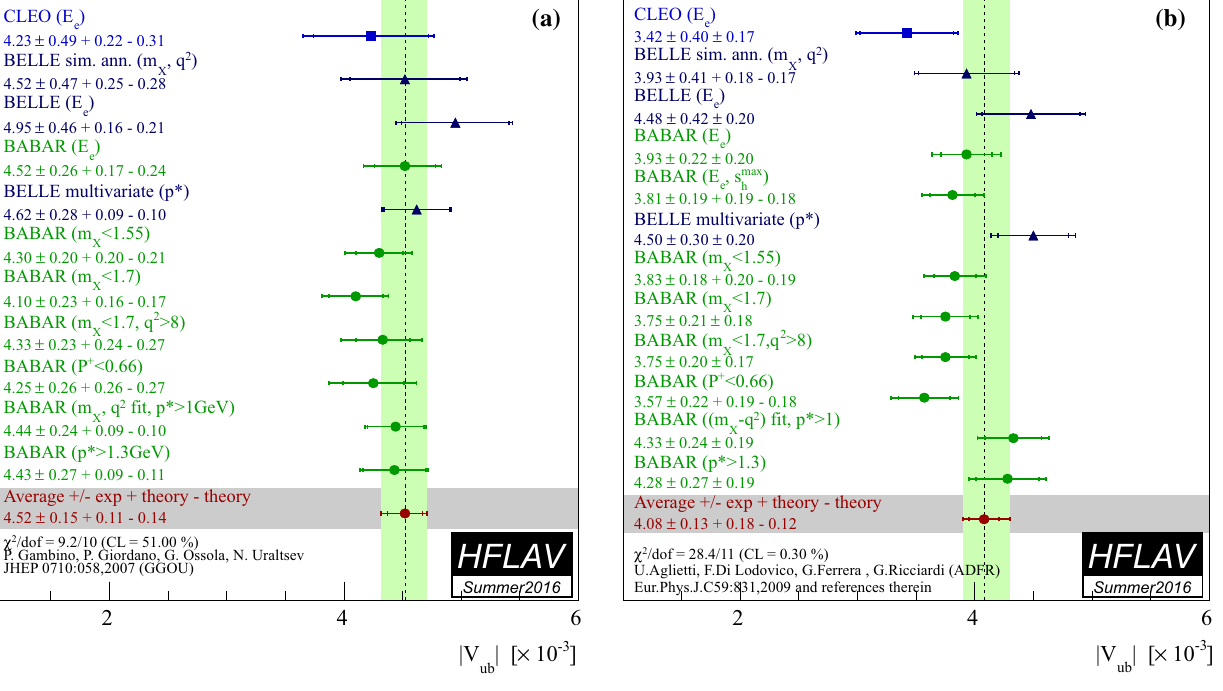
Fig. 64 Measurements of | V ub | from inclusive semileptonic decays and their average based on the GGOU ( a ) and ADFR ( b ) prescription. The labels indicate the variables and selections used to define the signal regions in the different